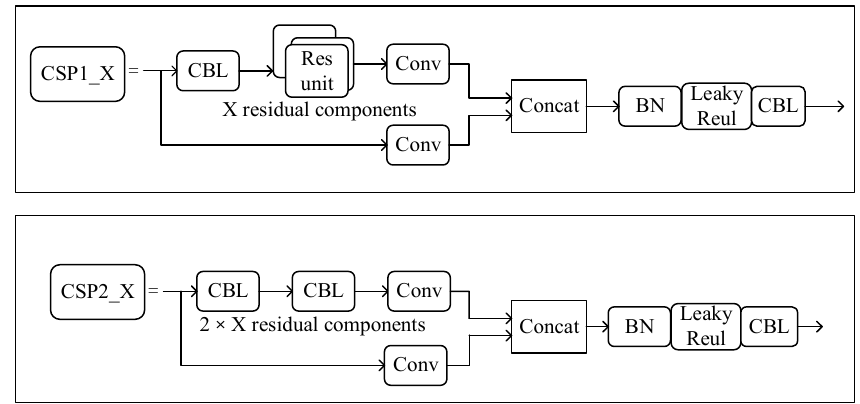
Figure 3. The structure diagram of CSP1_X and CSP2_X.